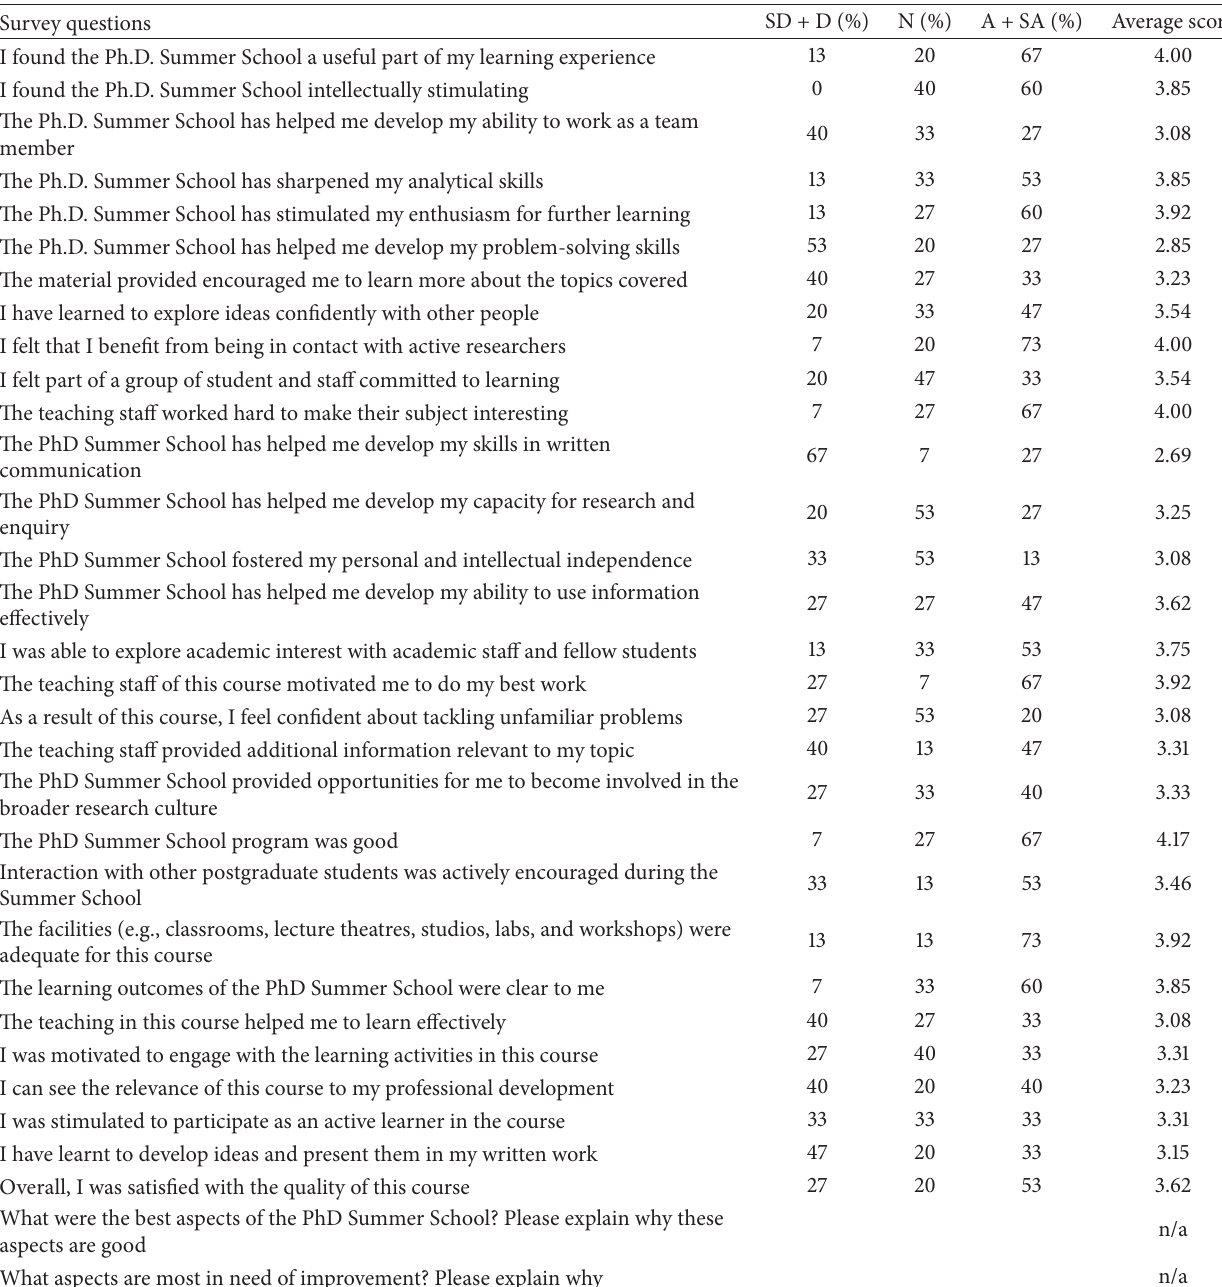
Table 2: Question delivered in the Ph.D. summer school evaluation form, cumulative percentages for SD + D (strongly disagree + disagree), N (neutral), and A + SA (agree + strongly agree) responses, and average